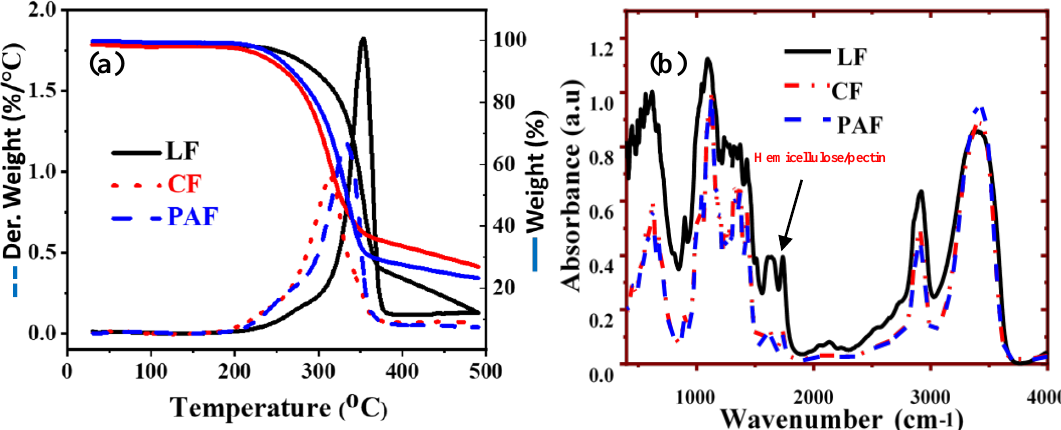
Figure 2. ( a ) Thermogravimetric TG (wt.%) and DTG (% / ◦ C) profiles and ( b ) Fourier-transform infra-red (FT-IR) spectral profiles of LF and its treated forms (CF and PAF).